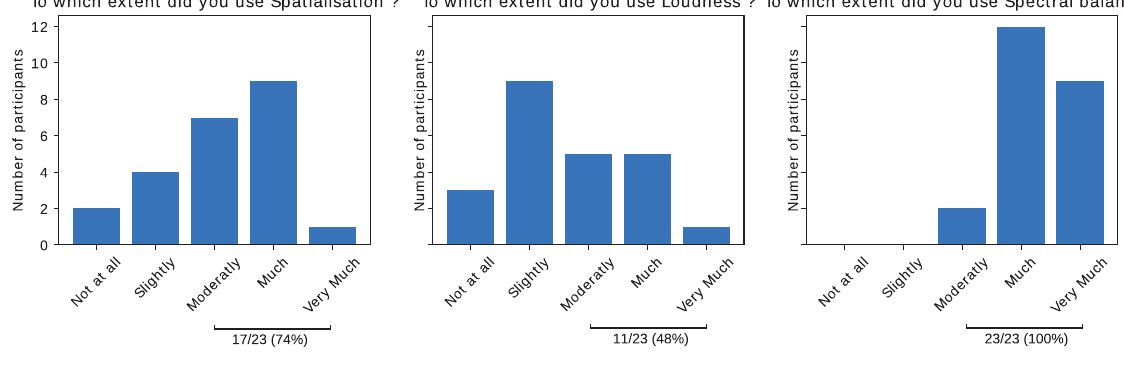
Figure 4. Number of participants who reported to use speci fi c sound features in the similarity task.